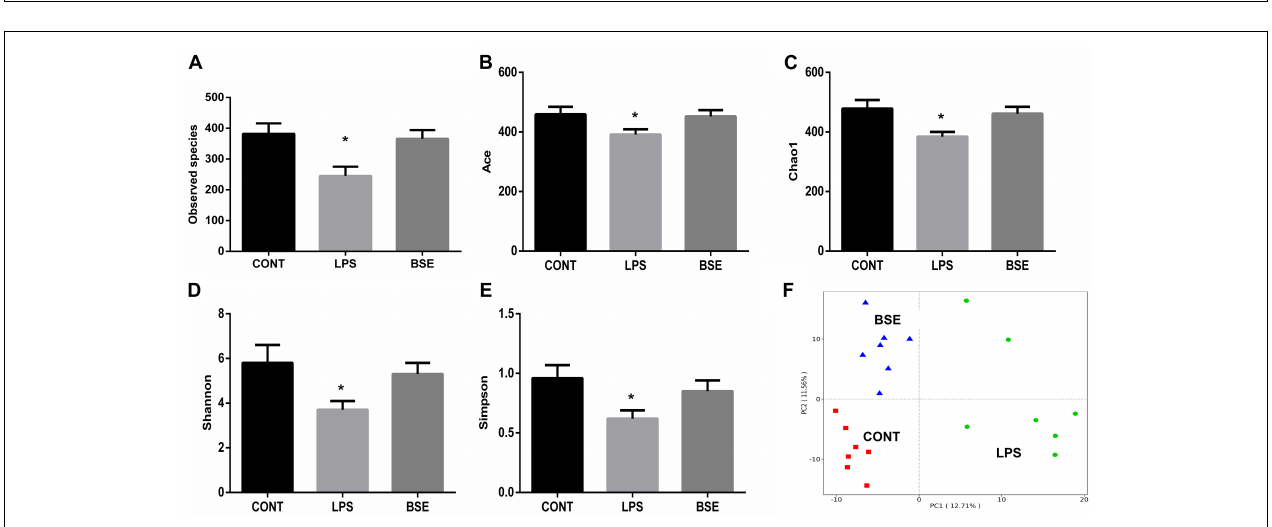
FIGURE 5 | Effects of Blidingia sp. extract on caecal microbiota diversity in lipopolysaccharide – challenged mice. (A) Observed species; (B) Ace; (C) Chao1; (D) Shannon; (E) Simpson; (F) PCoA plot of the microbiota based on an unweighted UniFrac metric. CONT, mice gavaged with sterile saline; LPS, mice injected with lipopolysaccharide; and BSE, mice gavaged with Blidingia sp. extract and injected with lipopolysaccharide. Values are expressed as mean ± SEM, n = 7; ∗ p <